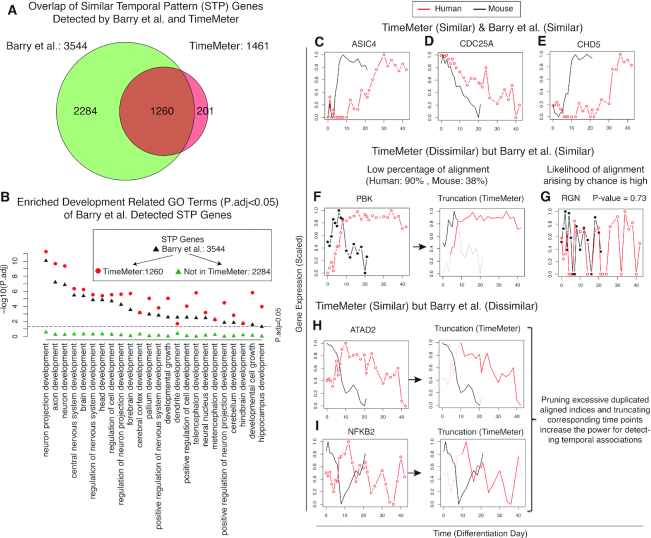
Comparison of TimeMeter and Barry et al. for detecting genes with similar temporal patterns (STP) between human ES (from day 0 to day 42) and mouse EpiS cells (from day 0 to day 21) during neural differentiation. (A) Overlap of STP genes detected by Barry et al. and TimeMeter. (B) TimeMeter significantly increases the specificity for detecting STP genes. Barry et al. detected STP genes are enriched in 24 development related GO terms (P.adj < 0.05) (black triangle). None of these development related GO terms is enriched (P.adj < 0.05) in Barry et al. only gene list. In contrast, 20 out of 24 development related GO terms showed noticeable increased statistical significance for 1260 STP genes which were also detected by TimeMeter. (C–E) Examples of STP genes detected by both TimeMeter and Barry et al. (F, G) Examples of STP genes which were detected only by Barry et al. but not by TimeMeter. (H, I) STP genes which were detected only by TimeMeter but not by Barry et al.